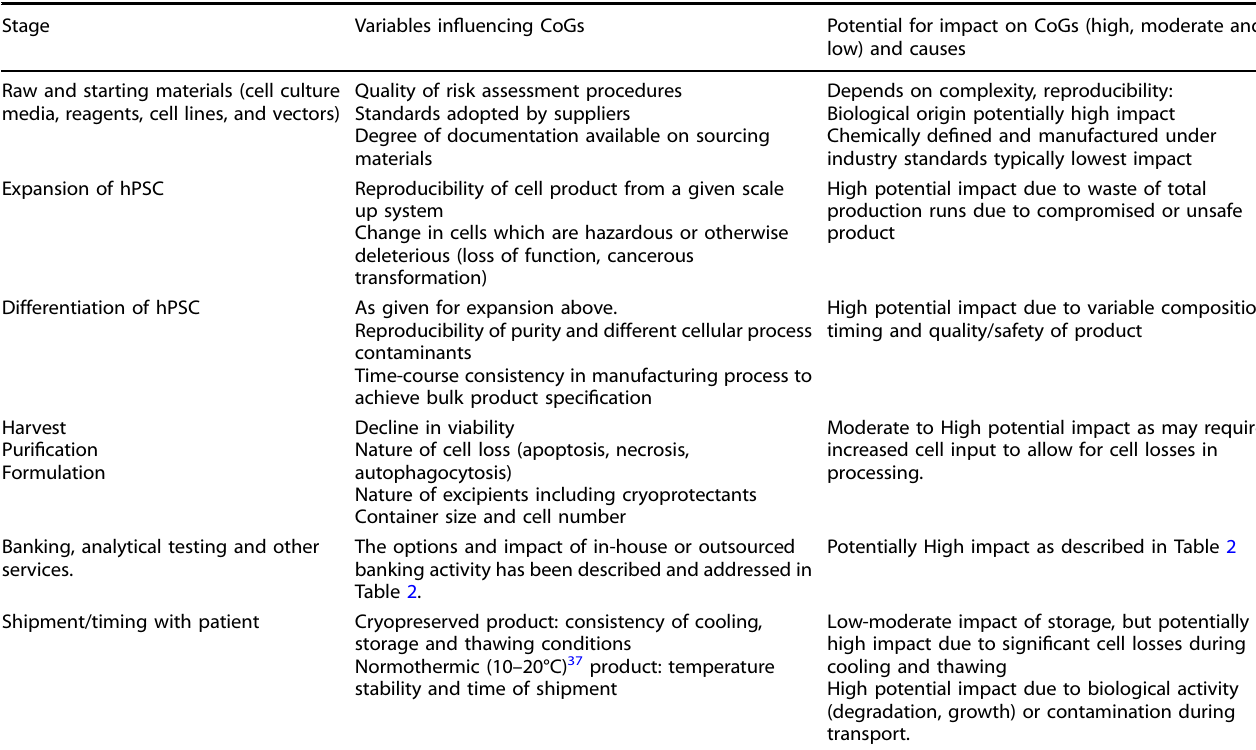
Table 3. Some key variables in hPSC cell banking and